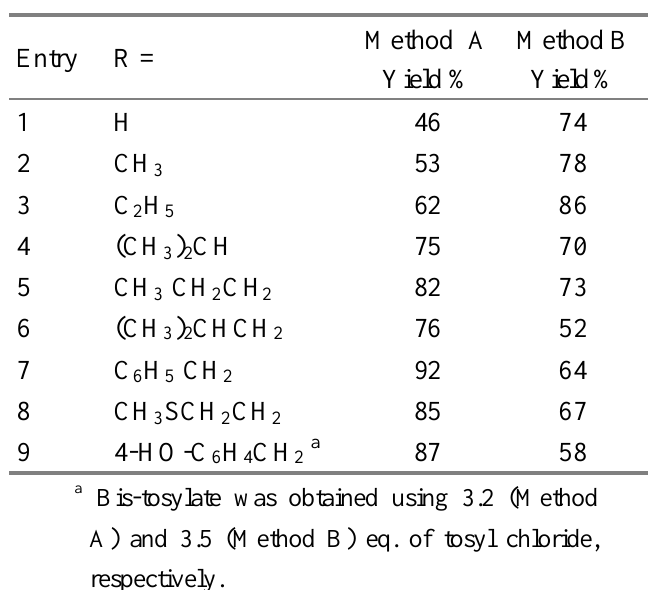
Table 1 . Direct synthesis of (S)-N-tosyl aziridines 1 from (S)-amino alcohols 2